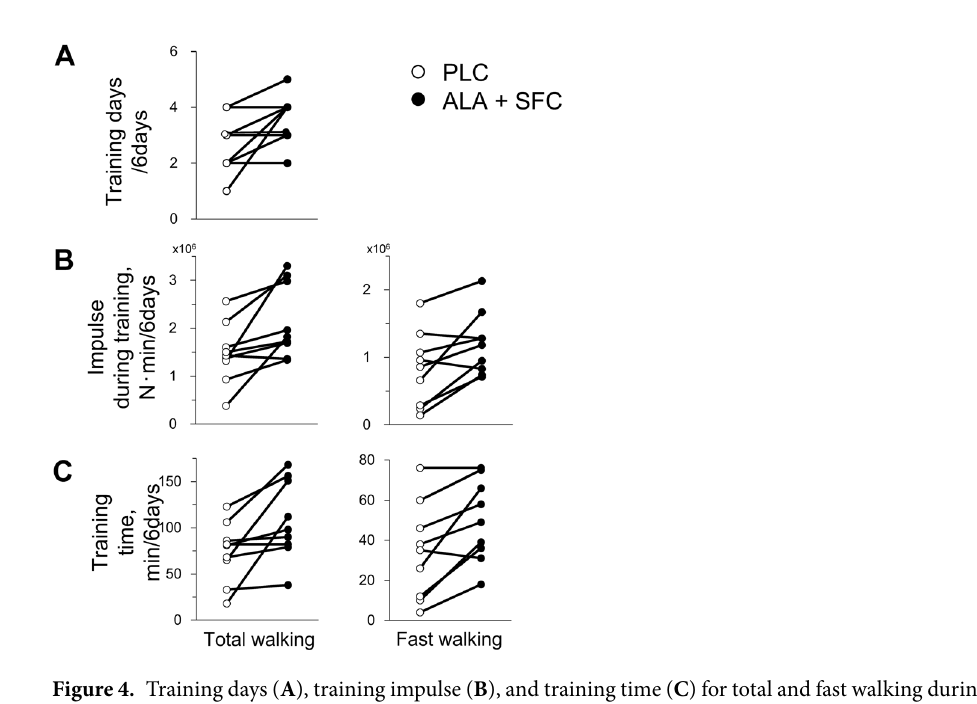
Figure 4. Training days ( A ), training impulse ( B ), and training time ( C ) for total and fast walking during a supplement intake period. Individual values are presented for 9